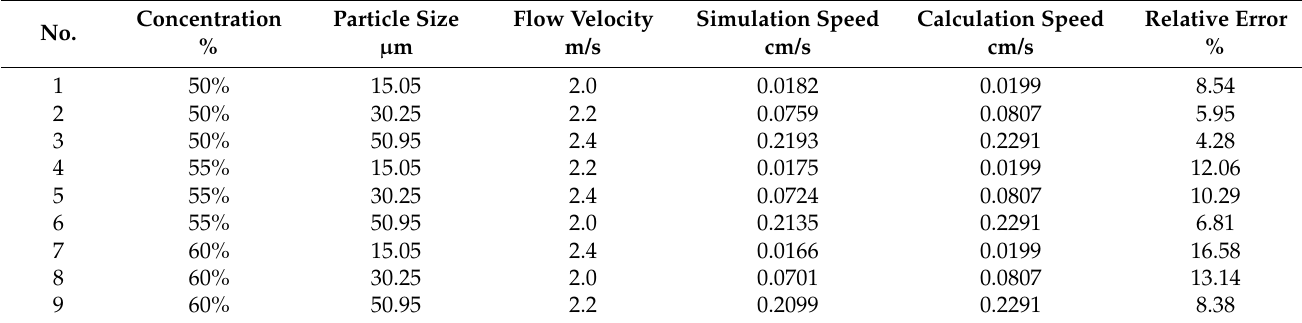
Table 7. Results of experimental simulation and actual calculation.